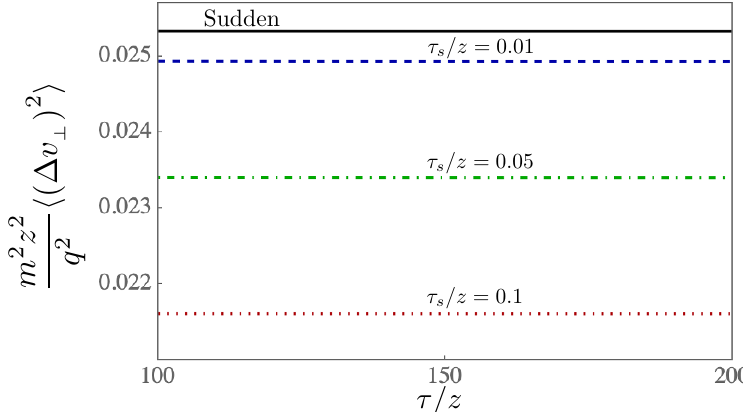
Figure 2 . Late time behaviour of the dispersion of the particle velocity in the perpendicular direction, described by eq. (3.5), as function of (cid:28)=z for some suggestive values of the ratio (cid:28) s =z